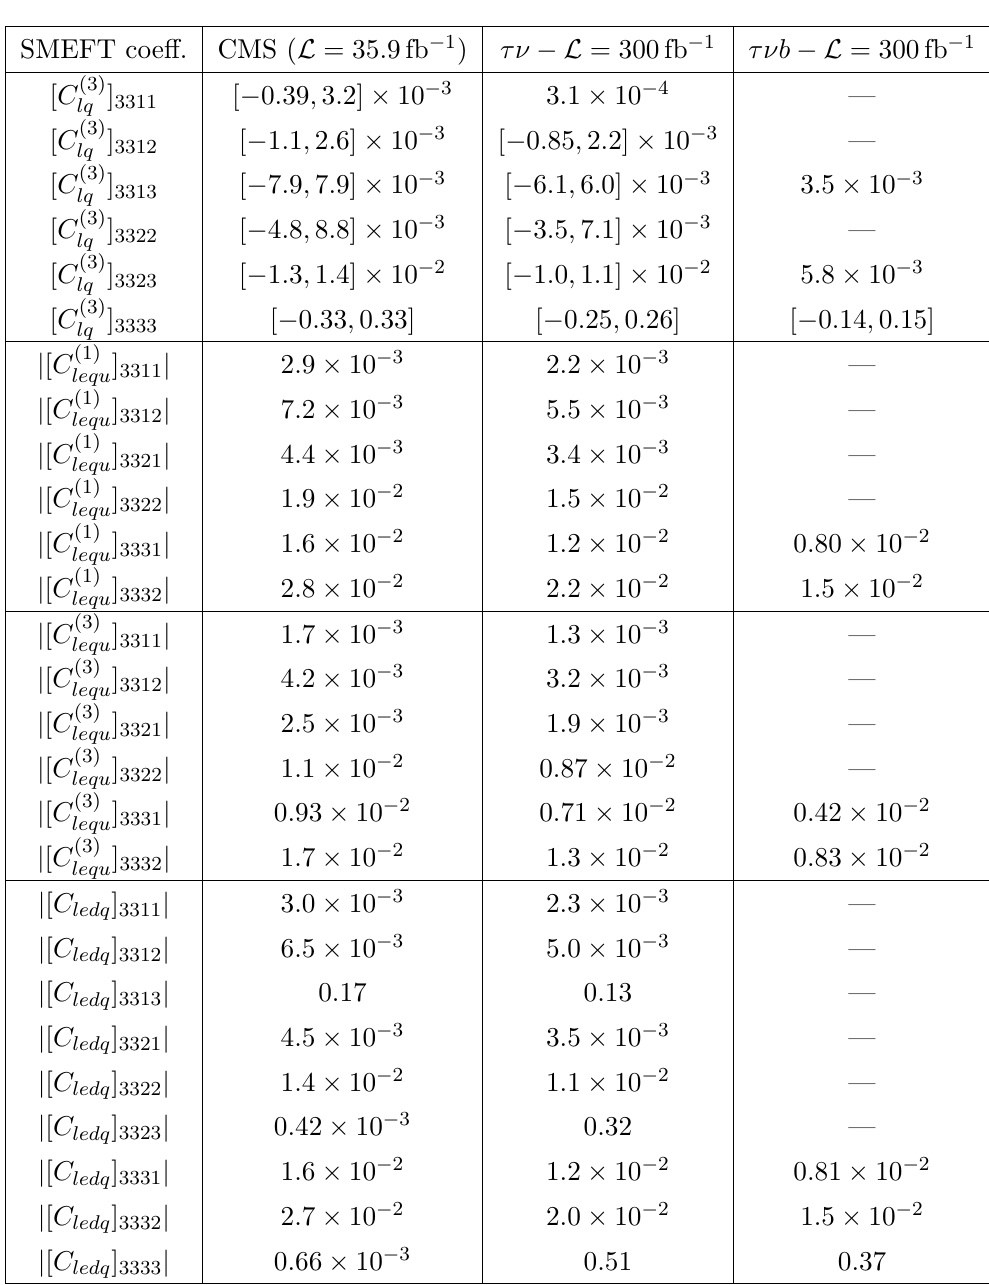
Table 5 . In the second column we show the recasted 95% CL intervals for the SMEFT coefficients defined in eq. (1.1), evaluated at the 1 TeV scale and switched on one at a time, using the CMS τν √ analysis at s = 13 TeV and an integrated luminosity of 35.9 fb − 1 . In the third and fourth column we show the prospects for a luminosity of 300 fb − 1 , for the same τν analysis and the τν + b -jet analysis we propose,